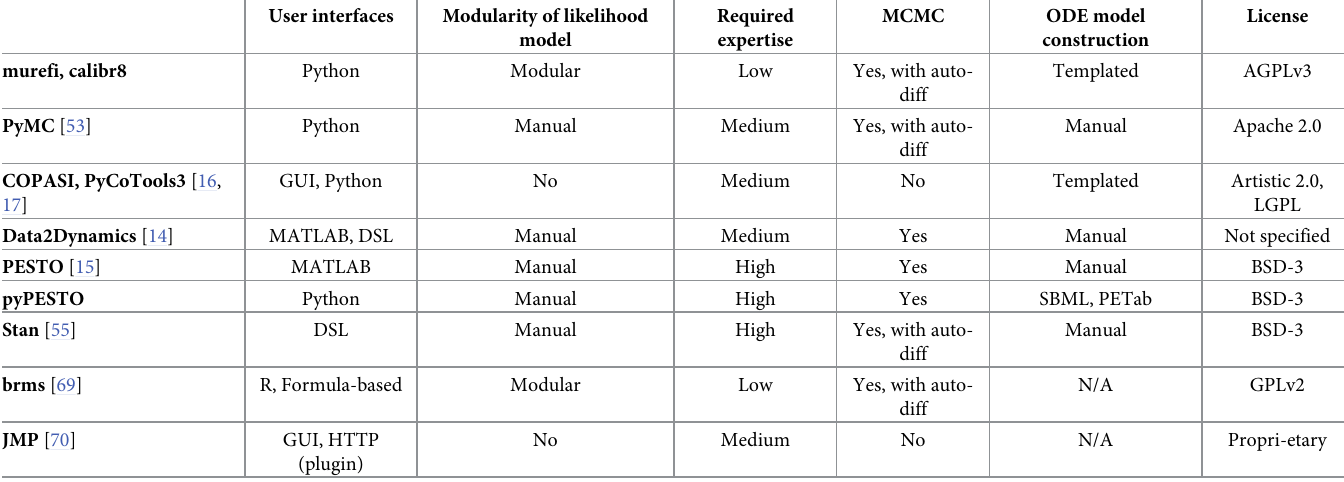
Table 2. Comparison with related software packages. DSL: Domain-Specific Language, GUI: Graphical User